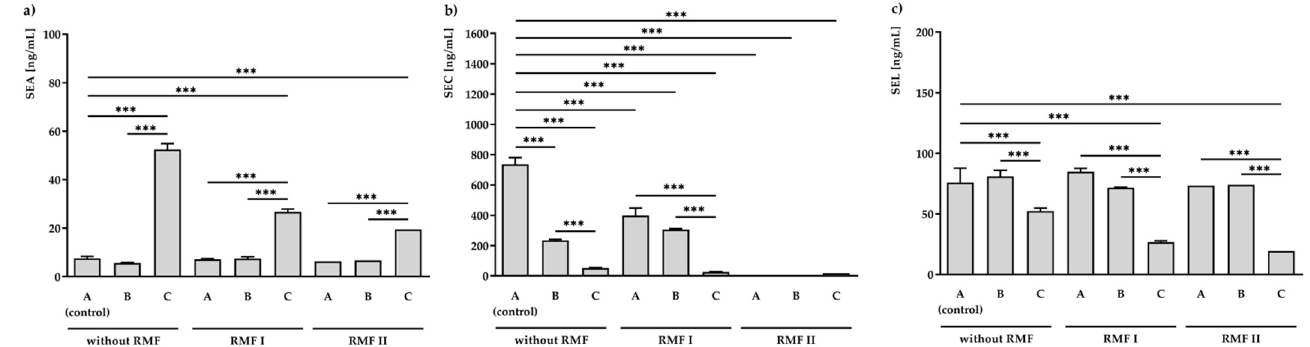
Figure 2. ELISA analysis of staphylococcal enterotoxins: SEA ( a ), SEC ( b ), and SEL ( c ) production in S. aureus FRI913 grown on Mueller–Hinton agar non-supplemented with trans -anethole (A), supplemented with 1% ( v/v ) Tween 80 (B), and supplemented with 1% ( v/v ) Tween 80 and subinhibitory concentration of trans -anethole (C), exposed to rotating magnetic fields (RMFs: RMF I: 5 Hz, RMF II: 50 Hz) and unexposed (without RMF). Control—bacteria cultured on a medium non-supplemented with trans -anethole (A) and unexposed to RMFs. Data are shown as the mean ± standard deviation. *** p < 0.001.